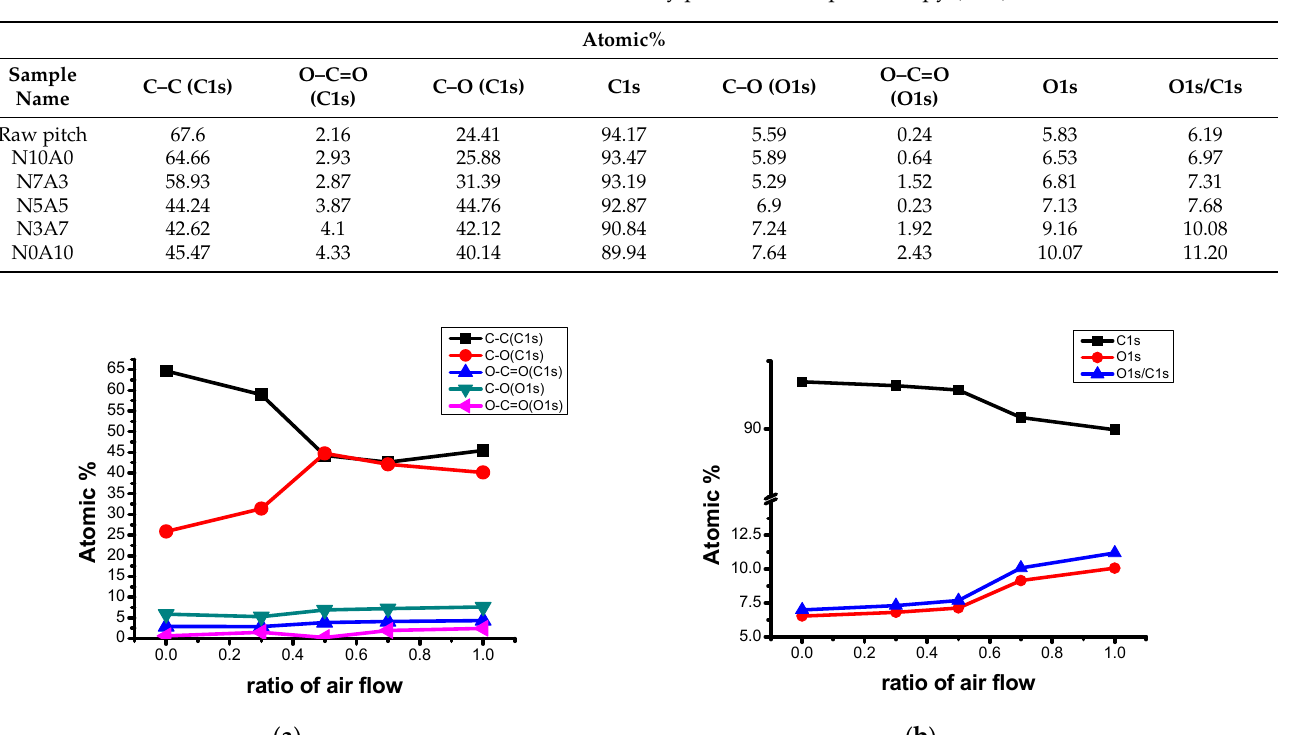
Figure 2. X-ray photoelectric spectroscopy (XPS) C1s of binderless cokes manufactured according to flow ratio of nitrogen and air. Table 4. Atomic% of C1s and O1s from X-ray photoelectric spectroscopy (XPS).